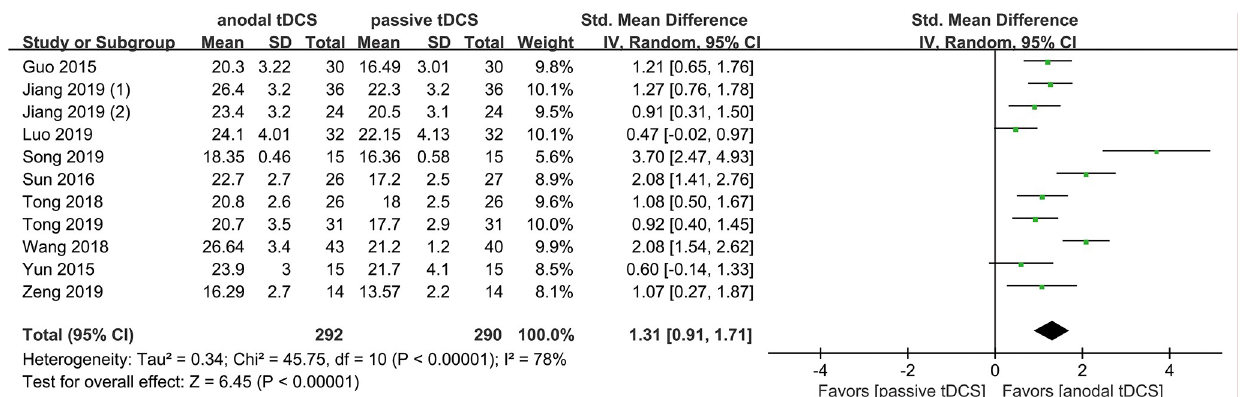
Fig 2. Forest plot of general cognitive function assessed by MMSE or MoCA.